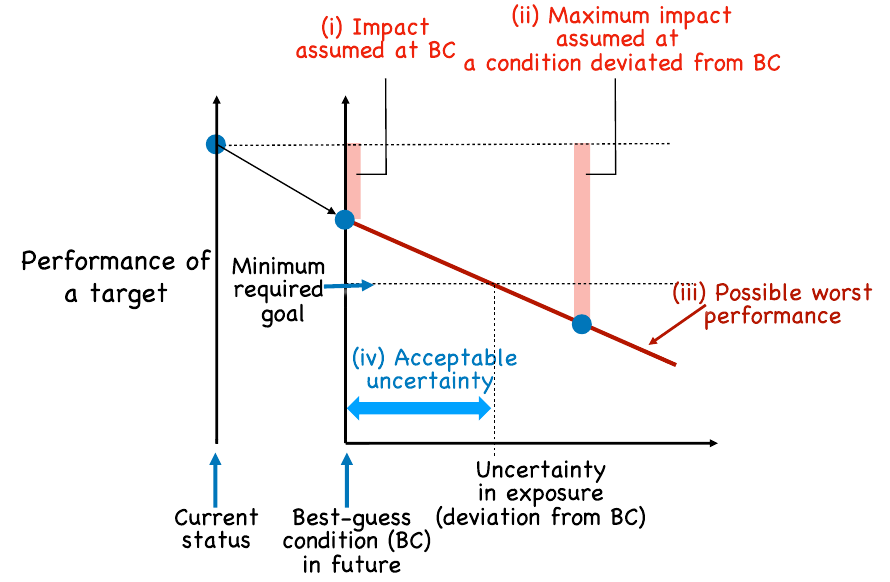
Figure 2. The proposed framework for vulnerability assessment under uncertainty in climate change predictions. In this figure, performance of a target system (e.g., ecosystem services or variables related to them) is expected to decrease from the current status under the future best-guess condition (BC). This decrease can be seen as an impact under BC (i). When a condition deviates from BC, and by focusing on the maximum impact within the deviation (degree of uncertainty) (ii), the possible worst performance decreases more (iii). When a minimum required goal is set, acceptable uncertainty for the minimum required goal can be determined (iv), which is a metric for the robustness (i.e., anti-vulnerability) considering uncertainty in